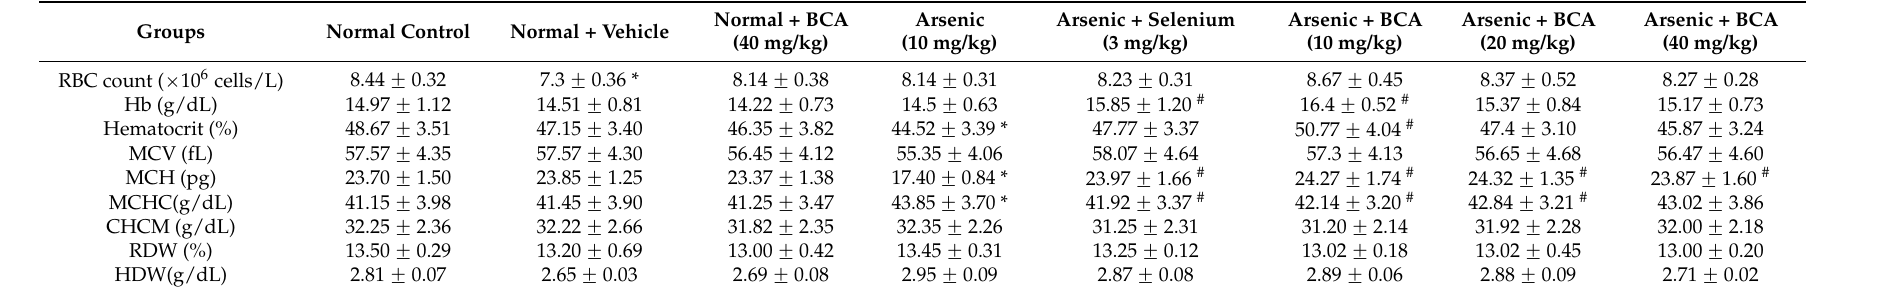
Table 3. RBC indices of normal control and experimental rats.